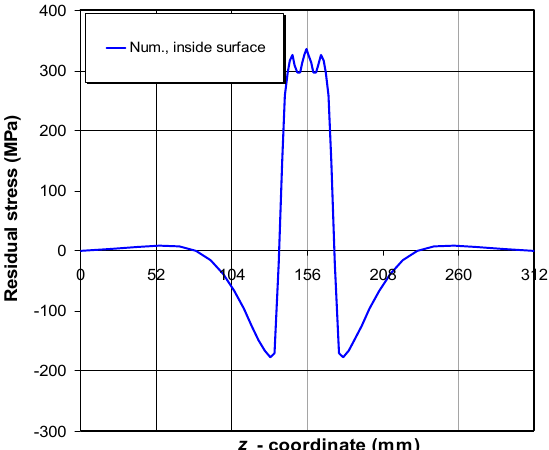
Figure 13. Hoop residual stress distribution on outside surface of welded pipes along line z 1- z 2 (Figure 2), α = 270°.